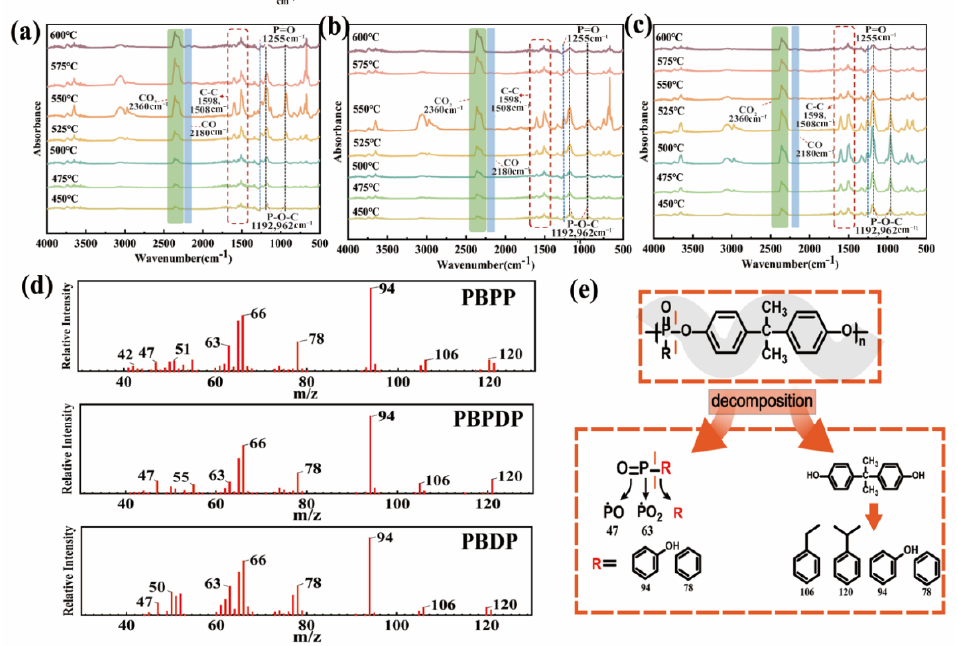
Figure 6. TG-FTIR spectra of pyrolysis products of PBPP, PBPDP and PBDP ( a – c ), the pyrolysis processes of flame retardants ( d , e ).